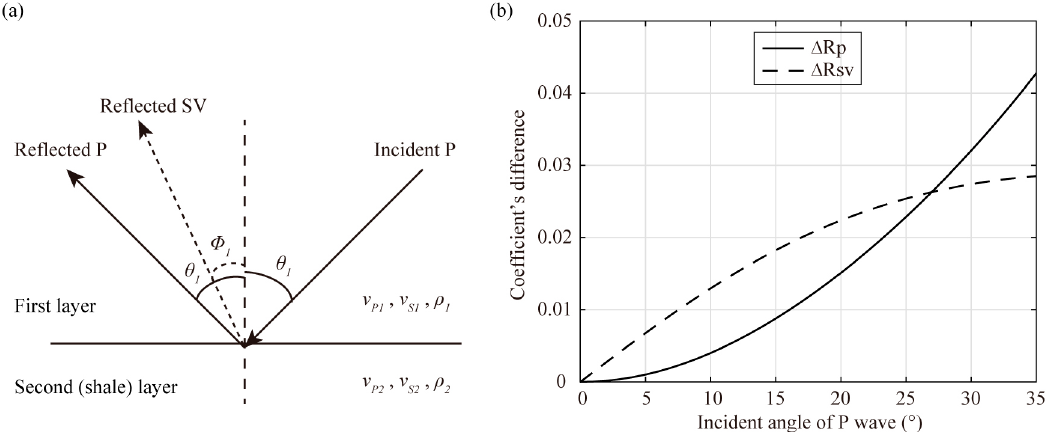
Figure 5. Schematic diagram and coefficients’ differences of reflected waves at the interface. ( a ) Reflection at the interface between first and second (shale) layer in the VTI model (Figure 2). θ (cid:2869) and ϕ (cid:2869) are the angles of P and SV waves, respectively . ( b ) Reflection coefficients’ differences of models with and without anisotropy ( M ED and M 0 ). Solid and dash line indicates reflected P and SV waves,